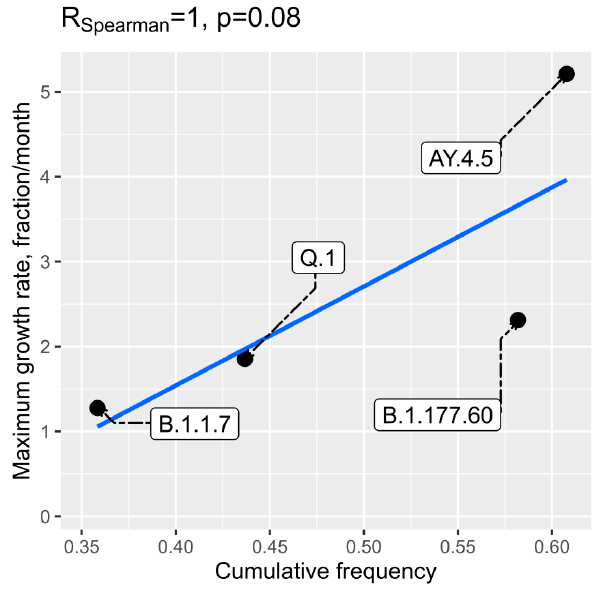
Figure 7. Relationship between frequency of transmission to Lithuania, as inferred from the time-scaled phylogenetic trees, and initial growth rate. On the x-axis, the sum of transmission frequencies from abroad to Lithuania, as inferred from the time-scaled phylogenetic trees, is given, and the y-axis matches the maximum first order derivative of the spline fitted to month fractions of the lineages.